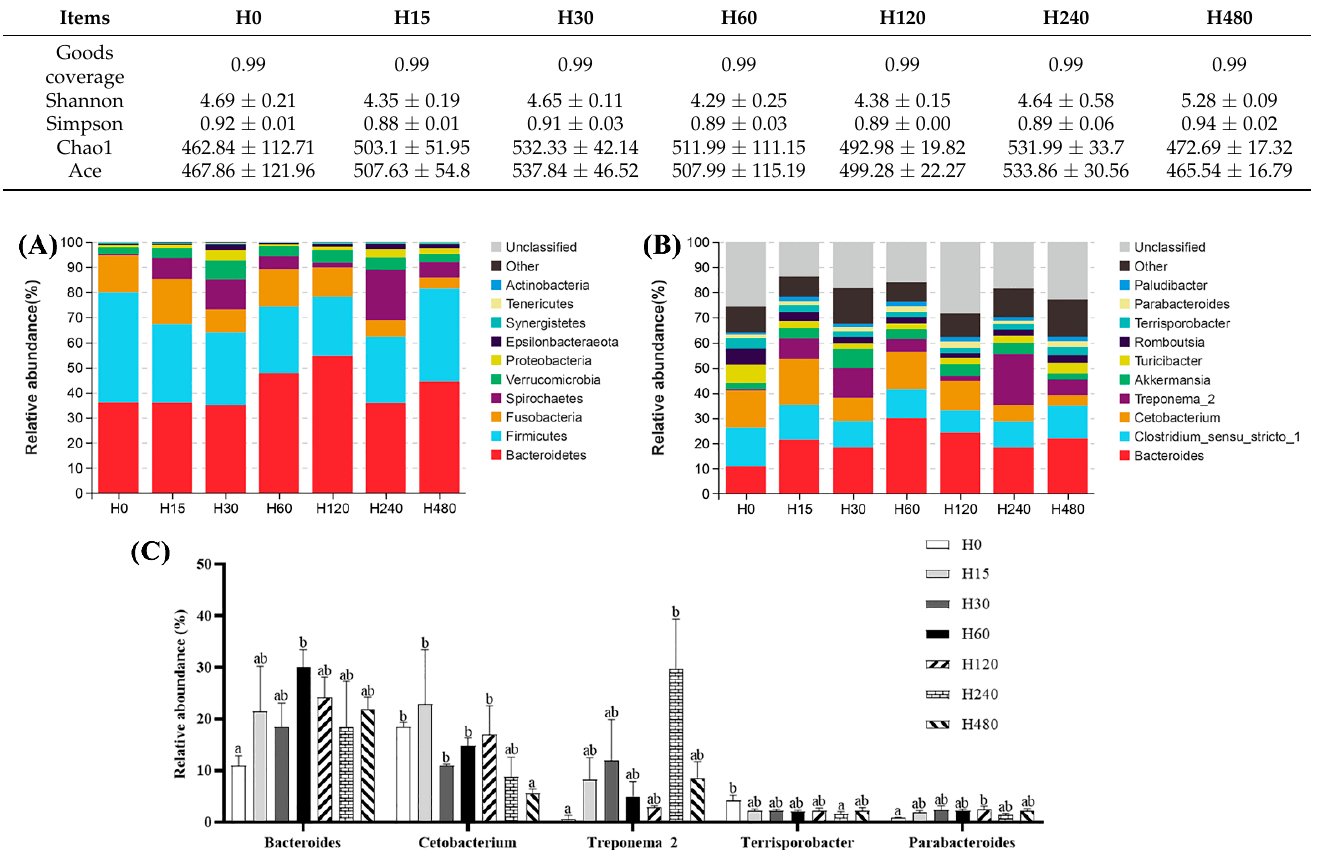
Figure 3. Intestinal flora composition of striped catfish fed with different experimental diets. ( A ), phylum level; ( B ), general level; ( C ), genera with significant differences. Values in each column with different superscripts represent significant differences ( p < 0.05).